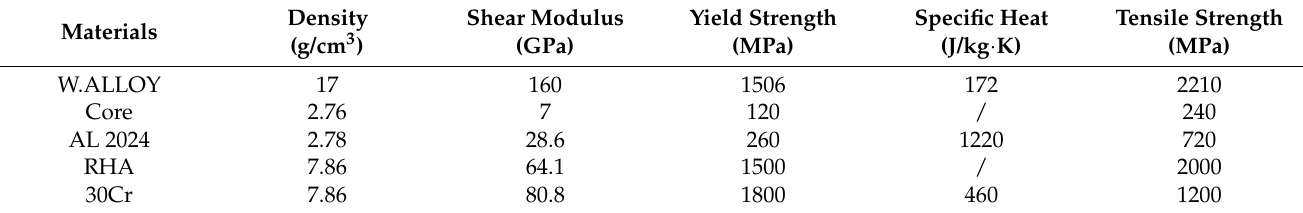
Table 2. Main materials parameter table.